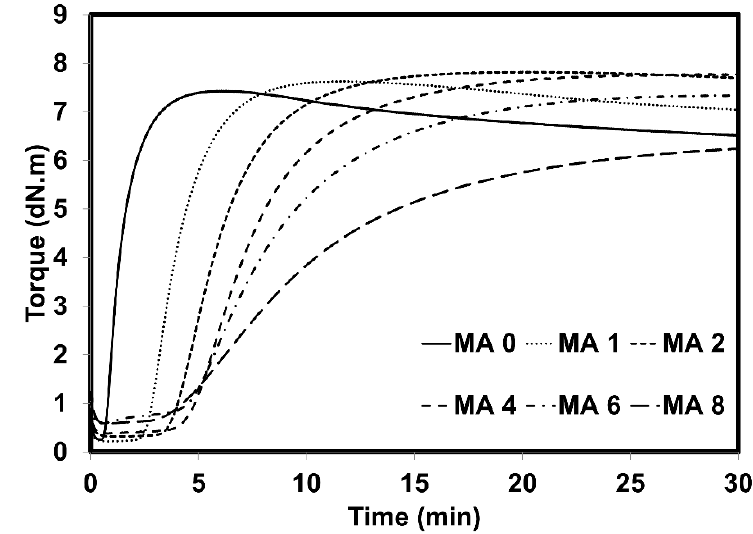
Figure 3. Tensile strength and elongation at break of NR/HNT and MNR/HNT composites. Table 3. Curing characteristics of NR/HNT and MNR/HNT composites.